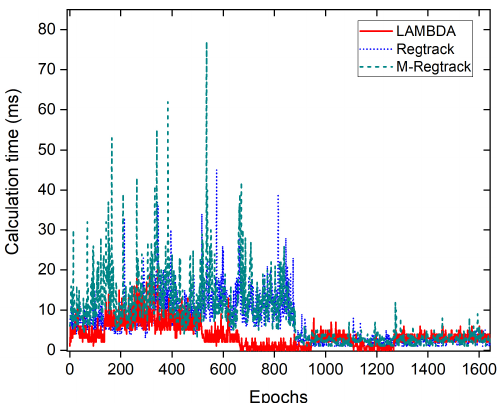
Figure 15. Calculation time in the kinematic